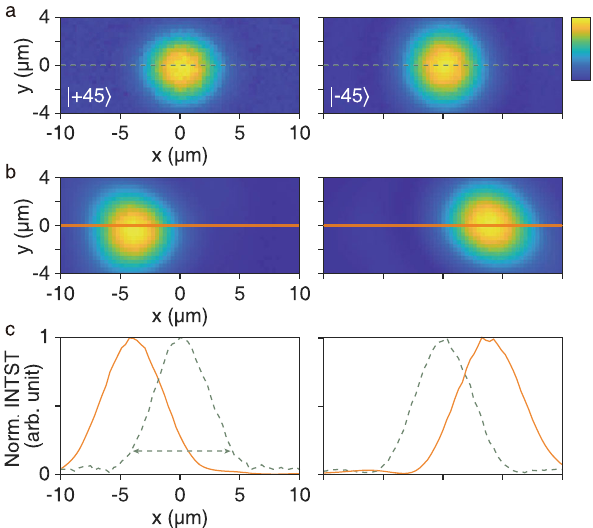
Fig. 4 Experimentally observed polarization-dependent lateral shifts. a The normalized intensity distributions of the original beam passing through an unstructured Si 3 N 4 window after the two setups of cross- polarized analyzing. The incident polarization states are marked on the plots, while the analyzed polarizations are orthogonal to the incident polarization. The positions of the beam centers are set as zeros of the coordinates. b The normalized intensity distributions of the beam passing through the fabricated PhC slab after the two setups of cross-polarized analyzing. The incident polarization state for each panel is the same as the one in a . c The normalized intensity distributions of the observed beams along the x axis, sliced from a and b . The dashed green curves correspond to the original beams shown in a , whereas the solid orange curves correspond to the shifted beams shown in b , correspondingly. The double- headed arrow marks the beam